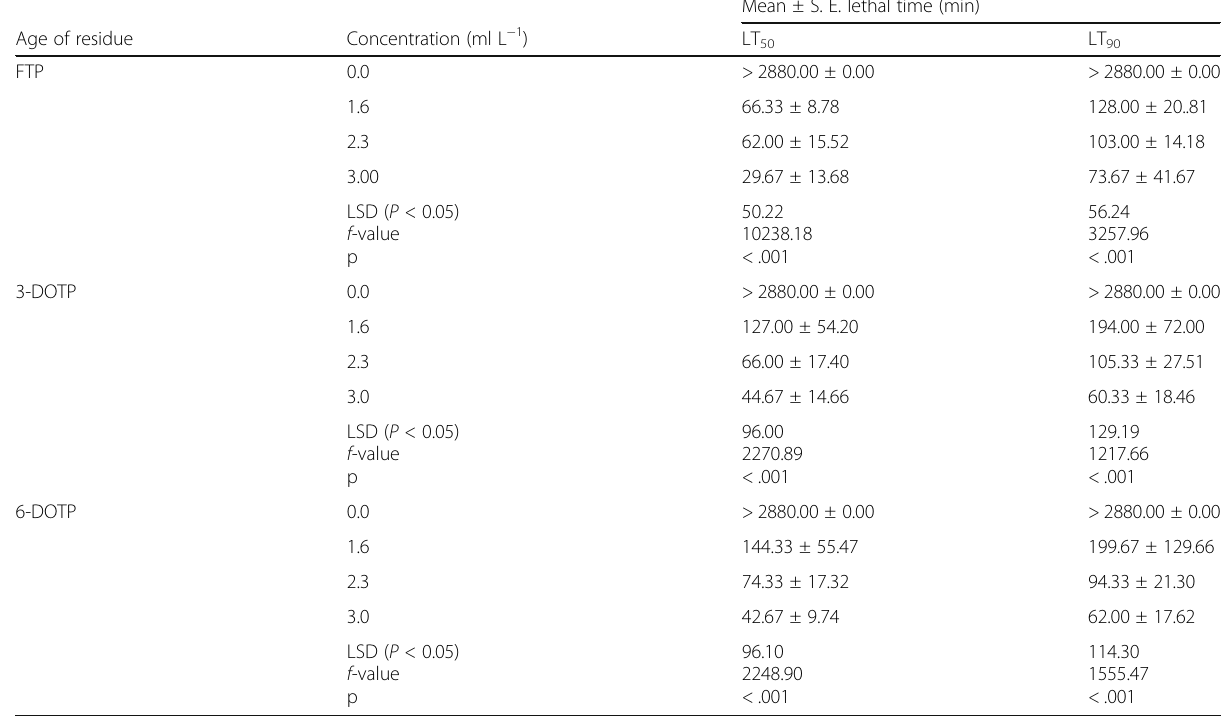
Table 2 Mean lethal time (LT) for different concentrations of cypermethrin+dimethoate (Cydim super) and age of